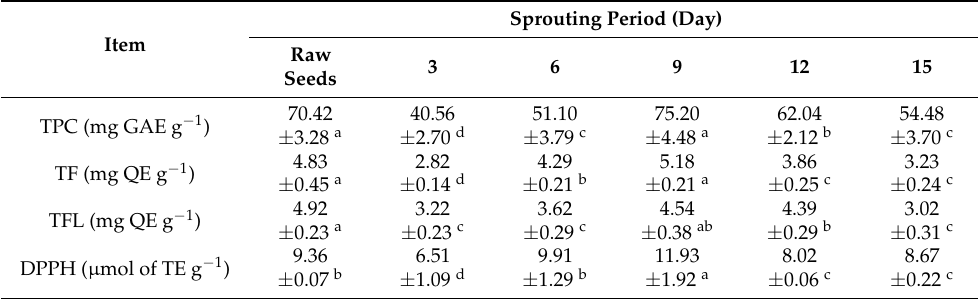
Table 1. Total phenolic content, total flavonoids, total flavonols, and potential antioxidant capacities of FS during sprouting at 17 ± 1 ◦ C and 90–93% RH (mean ± SE), n = 6.